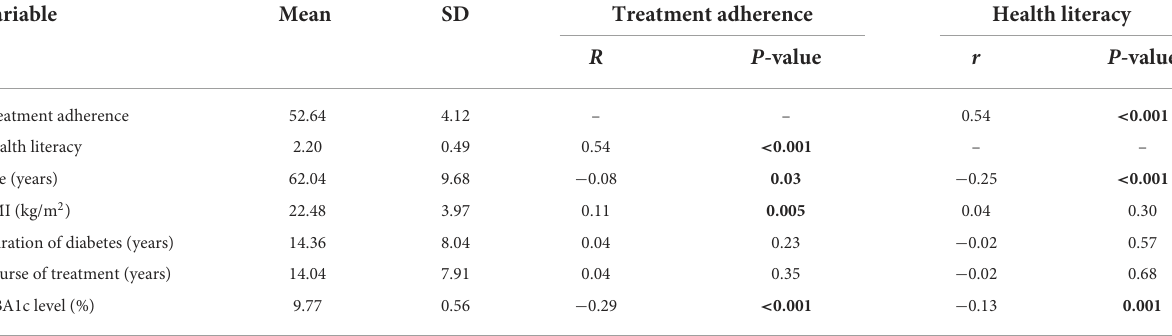
TABLE 1 Mean and standard deviation of quantitative demographic and characteristics and their relationships with treatment adherence and health literacy among study participants. Variable Mean SD Treatment adherence